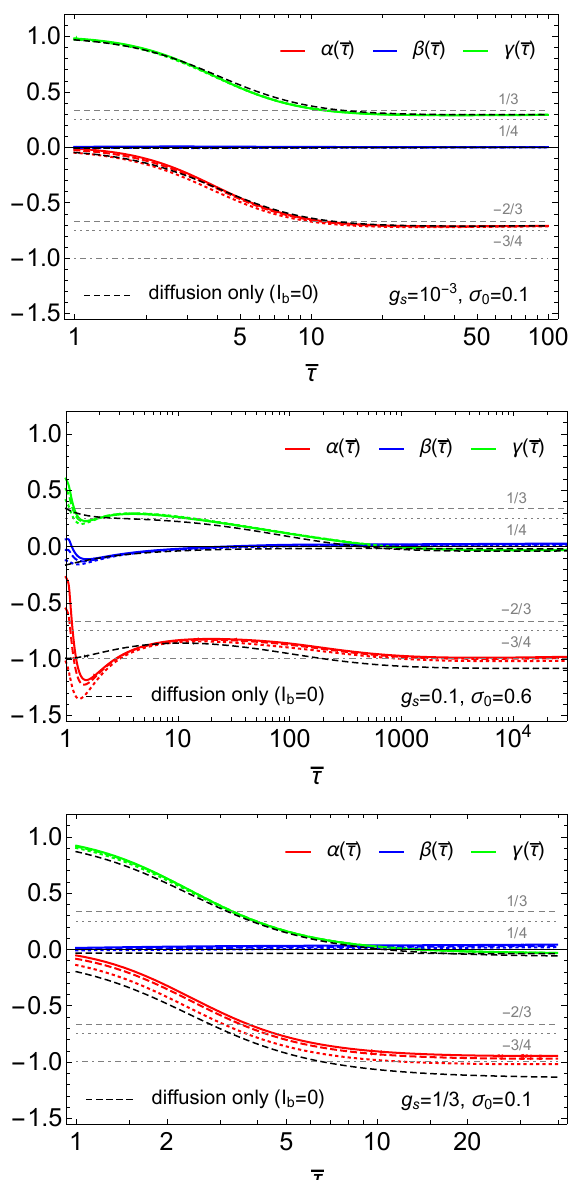
Figure 2 . Evolution of time-dependent scaling exponents α, β, γ for ( g s , σ 0 ) = (10 − 3 , 0 . 1) (top), (0 . 1 , 0 . 6) (middle) and (1 / 3 , 0 . 1) (bottom) as a function of the rescaled time coordinate ¯ τ = τ/τ I . Colored curves show exponents extracted from numerical solutions to the FP equation, with different dashing styles indicating exponents extracted from different combinations of moments in eq. (3.3). For comparison, black dashed curves show the exponents extracted from solutions with I b = 0 in the collision integral (2.9) (see text in the three final paragraphs of this section). We include dashed horizontal lines at the values of BMSS and dilute fixed points, and additionally at 1 / 4 and − 3 / 4 for visual